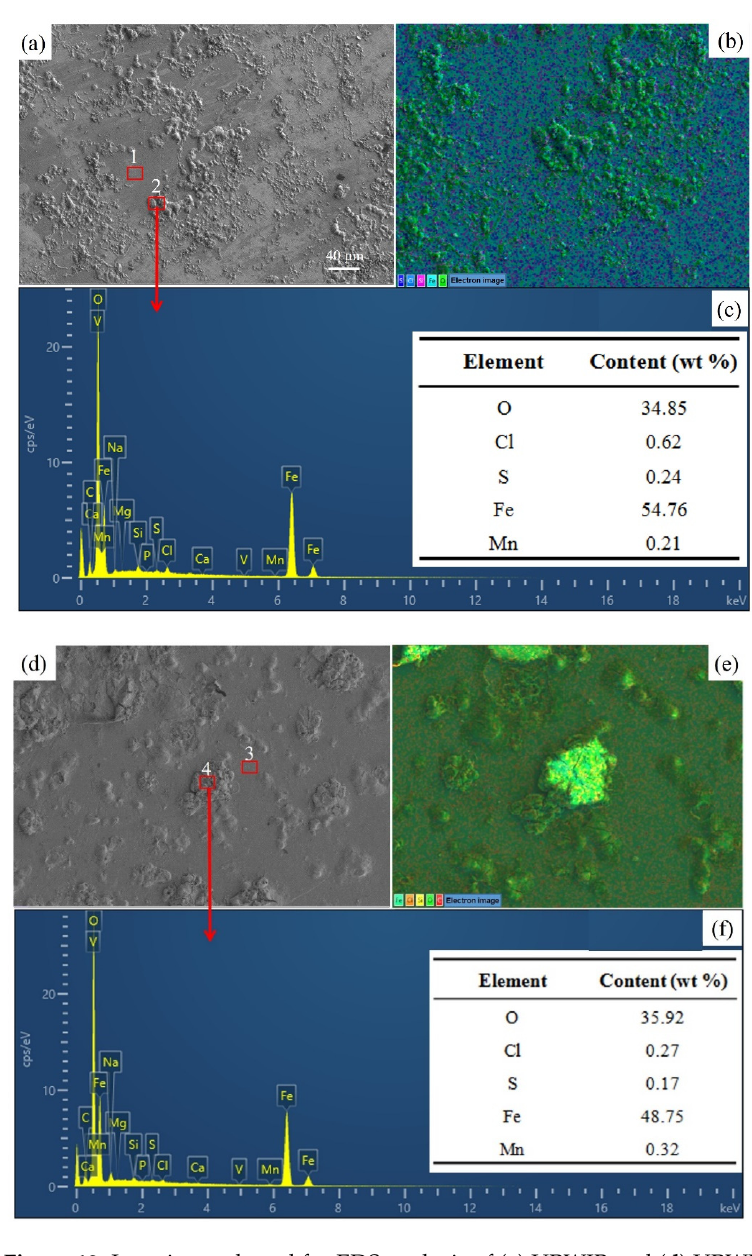
Figure 10. Locations selected for EDS analysis of ( a ) URWJB and ( d ) URWJA, local EDS spectra